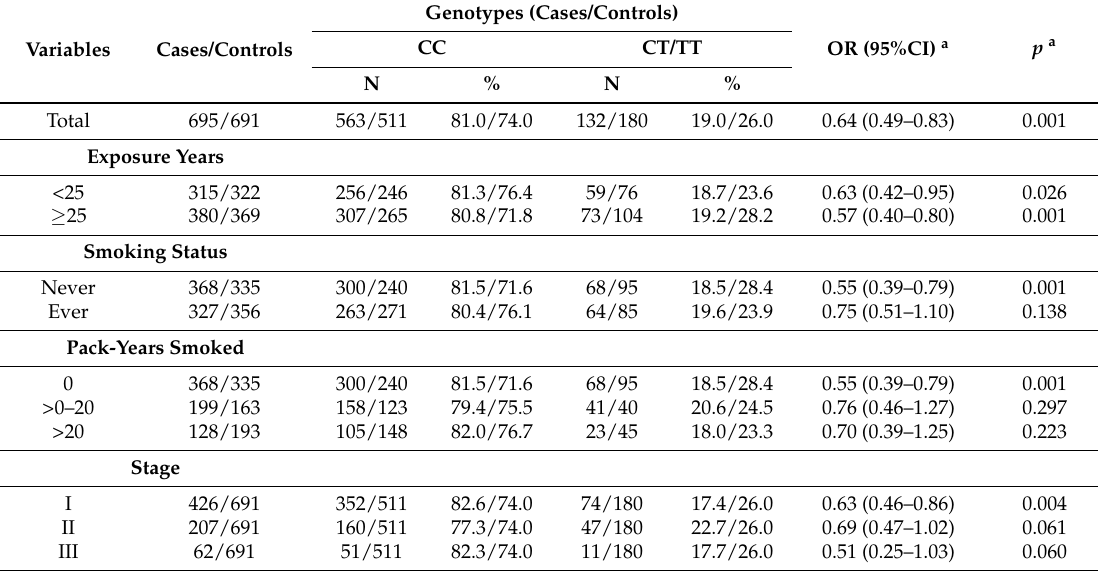
Table 4. Stratified analysis between the genotypes of H19 rs2067051 and the risk of coal workers’ pneumoconiosis